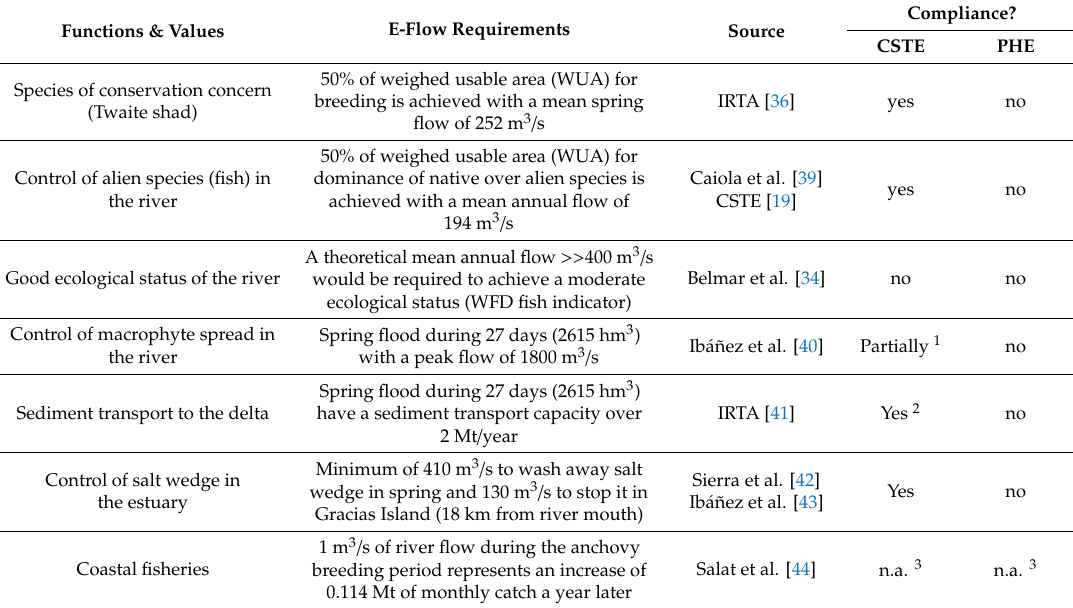
Table 2. Relationship between river flows and environmental functions and values that have been quantitatively assessed in the lower Ebro River and delta. Compliance with e-flow proposals is shown. Functions &